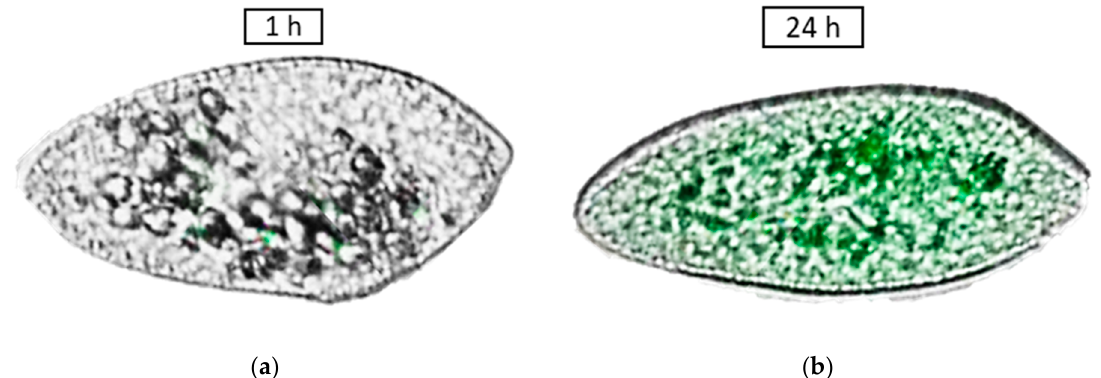
Figure 30. Representative dark field image of ( a ) control wild-type nematode (green arrow indicates the light scattered by tissue aggregates from nematode extraintestinal tissues) and of ( b ) a wild-type nematode exposed to 12.5 mg/L CeO2 NPs for 24 h (green arrow indicates ingested CeO2 NPs). (Modified after [144]